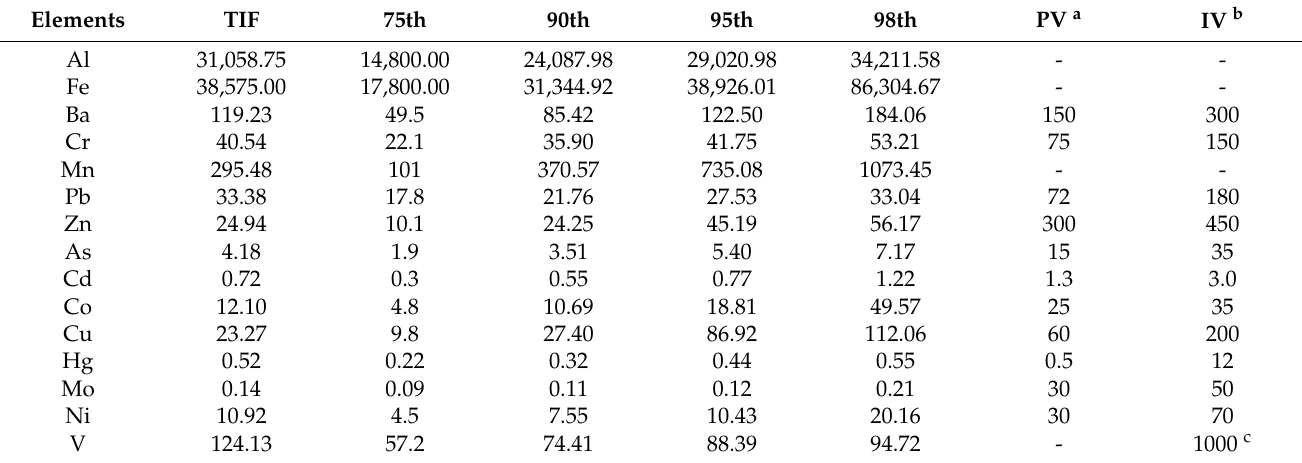
Table 3. Environmental thresholds for potentially toxic